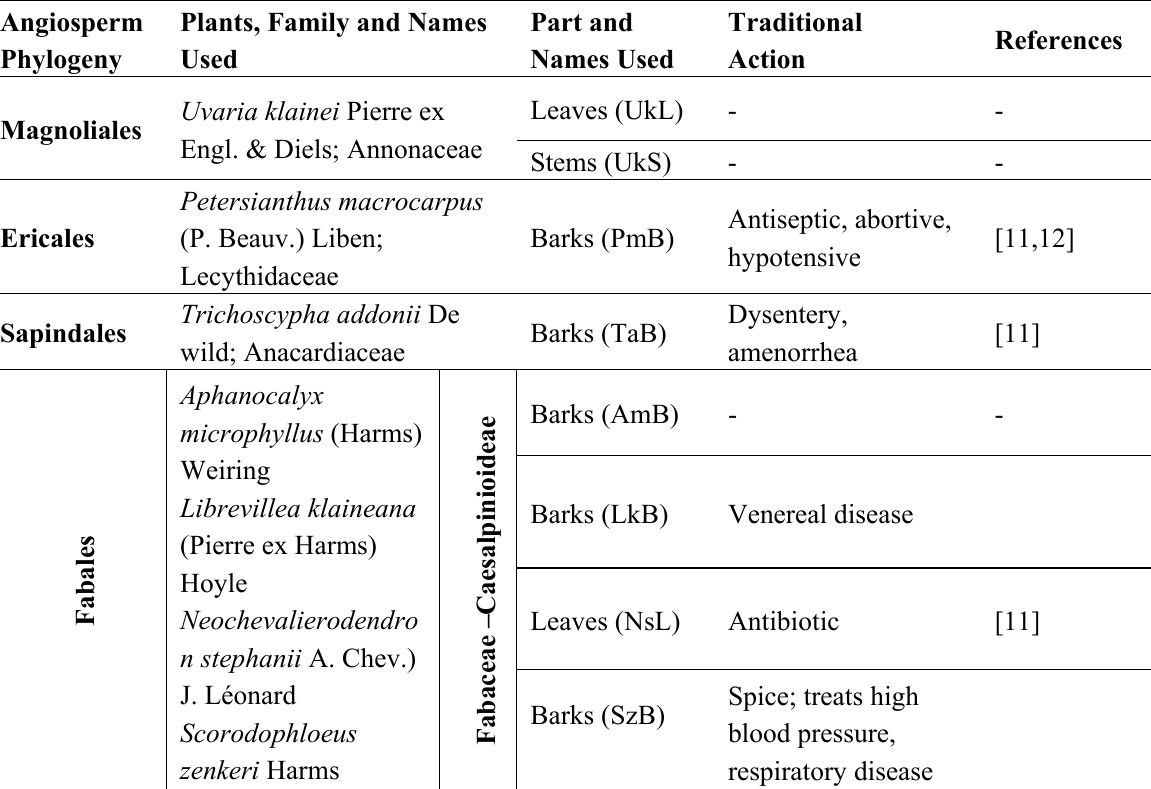
Table 1. List of plants endemic to Gabon investigated in this study. Please carefully check the